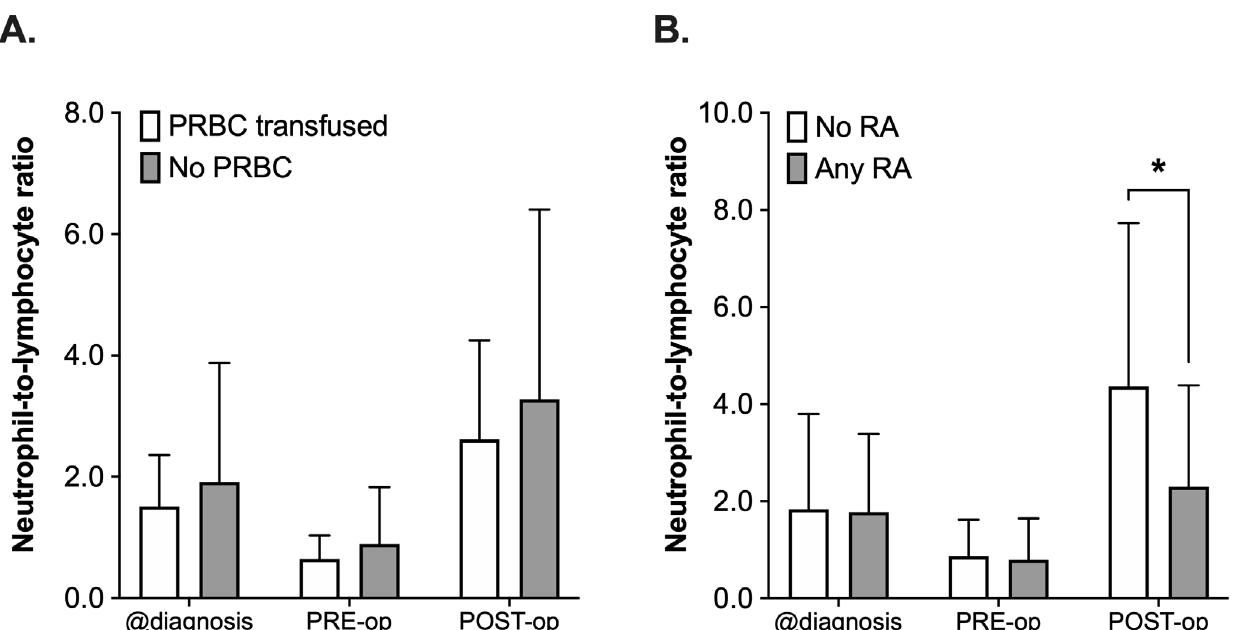
Figure 4. Analysis of neutrophil-to-lymphocyte ratio (NLR) in pediatric patients undergoing surgery for nephroblastoma at three different timepoints: at the time of diagnosis (@diagnosis), pre-operatively (PRE-op) and postoperatively (POST-op). Patients were categorized into groups in accordance with the according to their respective intraoperative treatment: ( A ) intraoperative administration of packed red blood cells (PRBC, white boxplots) vs. no administration of PRBC (grey boxplots) and ( B ) no regional anesthesia as part of the anesthetic regimen (white boxplots) vs. perioperative use of regional anesthesia (RA, grey boxplots). Data are presented as boxplots (median with quartiles, whiskers representing minimum and maximum). * p < 0.05 for comparison as indicated.